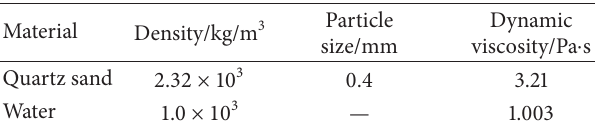
Table 2: The materials of fluid flow and the corresponding physical property